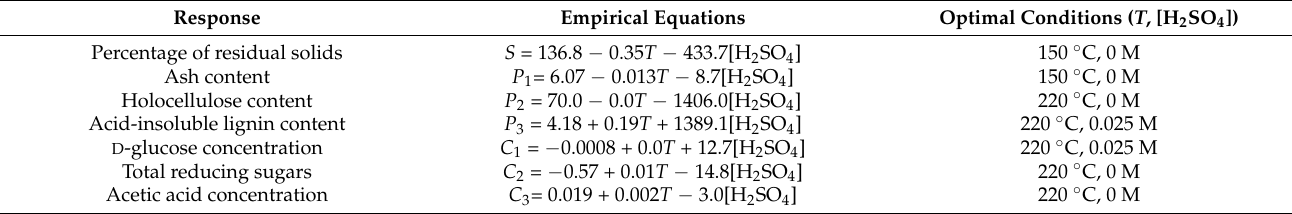
Table 5. Empirical equations for each response and adequate optimal conditions for thermochemical pretreatment of old cellulosic fibers ( ◦ C,